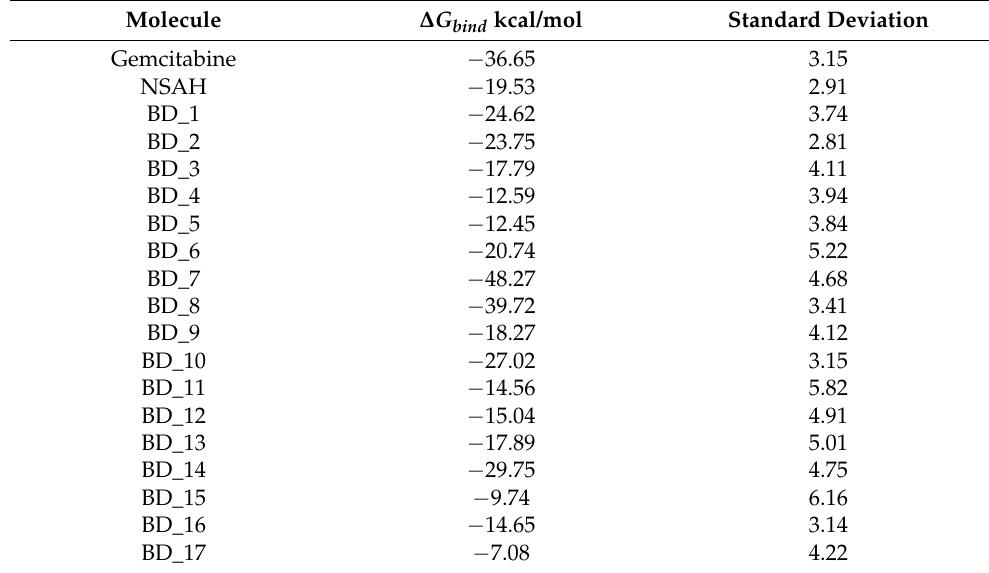
Table 4. Binding energy of the 17 best hRRM1 inhibitors, gemcitabine, and NSAH through the MM-GBSA